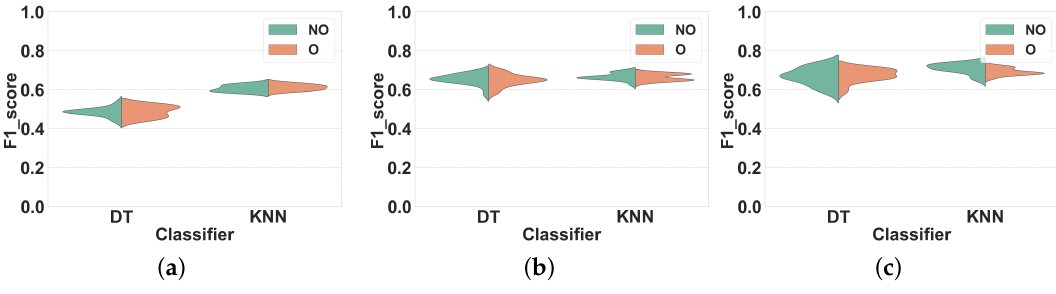
Figure 10. Experiment 3–Subject-independent CV–Dataset 2. ( a ) FS1; ( b ) FS2; ( c )